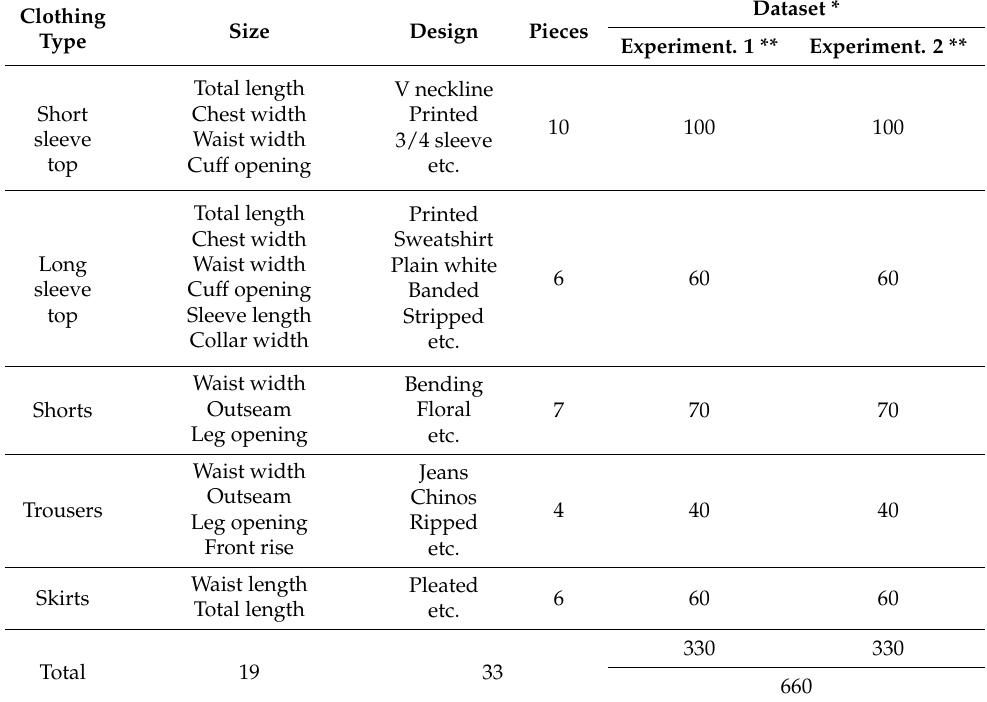
Table 1. Descriptionof garments in the dataset. For the experiments, we gathered 33 different designs of clothes from five clothing types. The dataset consists of 10 independent sets * (: image, depth map, and point cloud) for each garment. As shown in Figures A2 and A3, experiments 1 and 2 ** were conducted on a white background plate and a floor without a background plate,